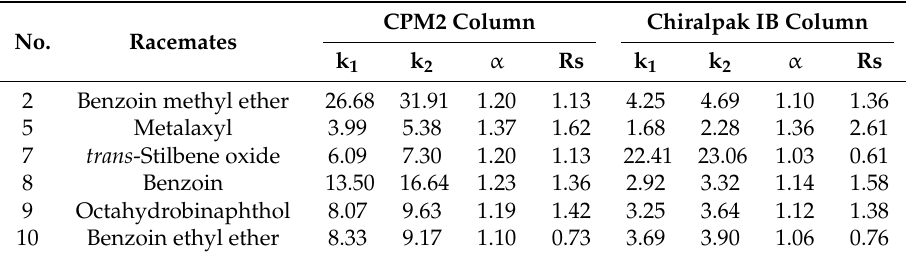
Table 3. Separation of racemates under reversed phase